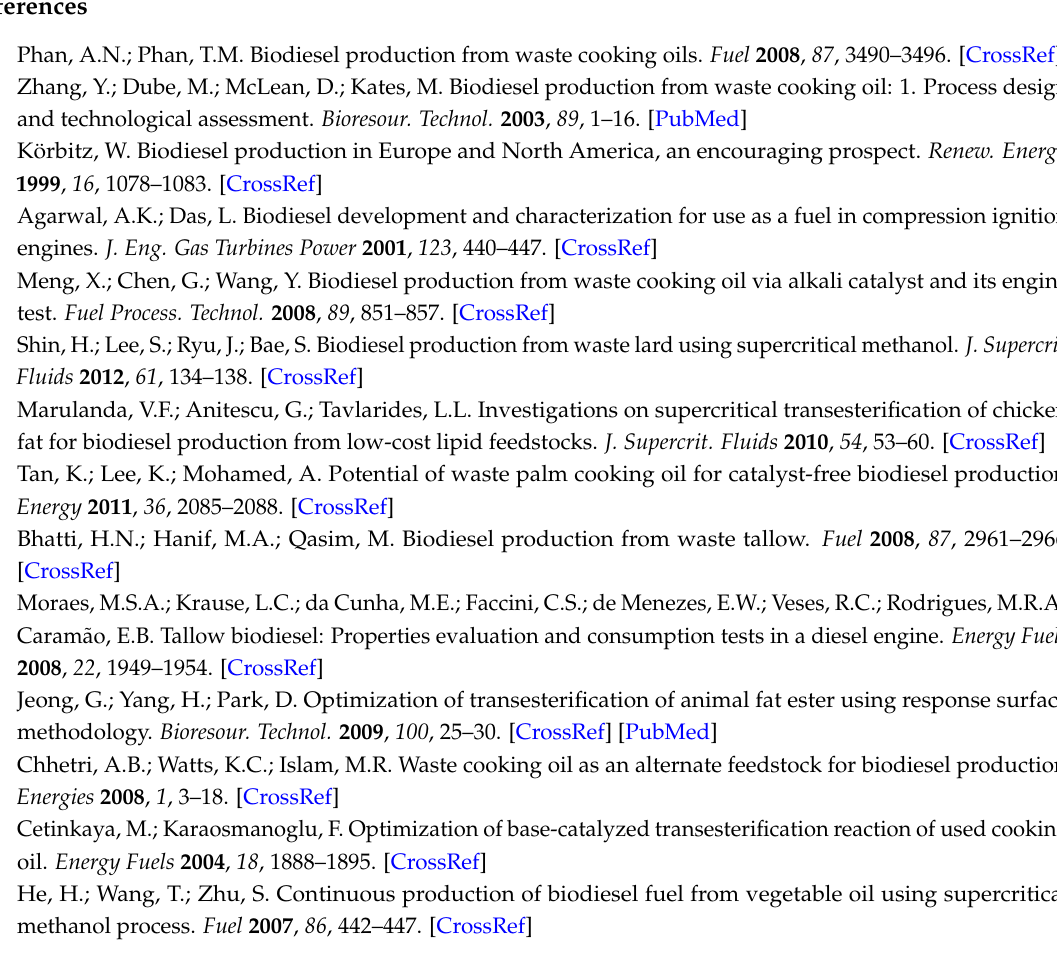
table; Jeeban Poudel, Malesh Shah and Sujeeta Karki wrote the draft of the paper; Sujeeta Karki was responsible for final editing and proofreading; Sea Cheon Oh supervised the research and finalized the paper. Conflicts of Interest: The authors declare no conflict of